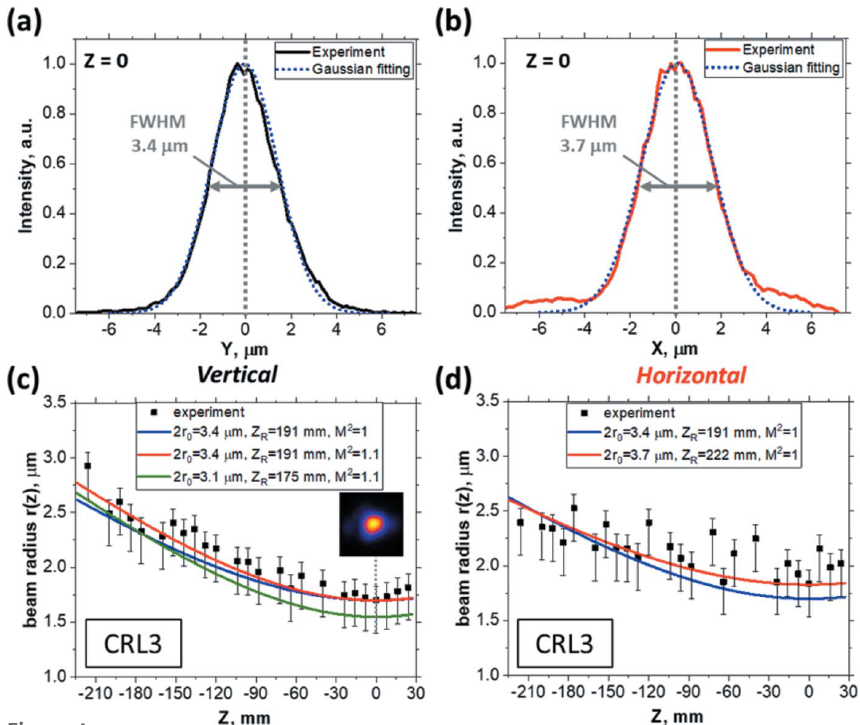
Figure 4 Parameters of the beam obtained in run #84 with combinations of lenses CRL1 (2, 6) and CRL3 (3, 4, 6): intensity profile in the spot with the smallest size (waist at Z = 0) in the vertical direction ( a ) and horizontal direction ( b ); dependence of beam radius r z (FWHM = 2 r z ) on position Z in the vertical plane ( c ) and horizontal plane ( d ). Experimentally measured data (black squares) are compared with theoretical caustics (colored lines). Fig. 4( d ), the caustic in the horizontal plane does not look like a hyperbola and is evidently different from an ideal Gaussian. This most likely originates due to the lens errors, and possible clipping of the beam.